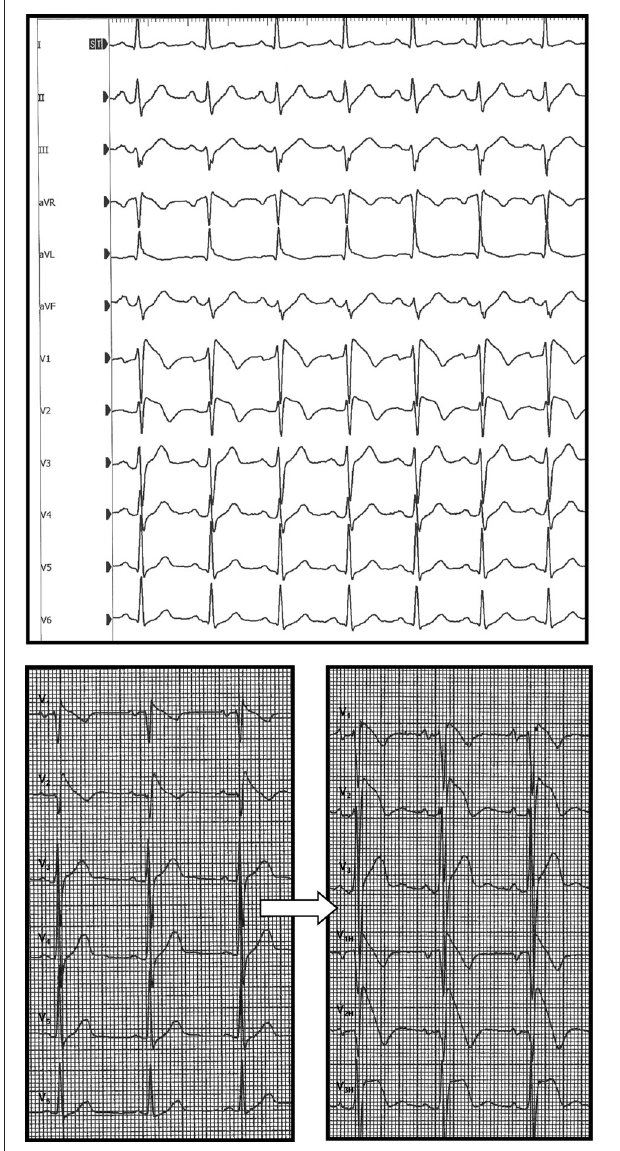
FIGURE 3 | Two typical BrS-ECGs (speed 25mm/s; gain 1mm/mV). Top: patient 33 with a baseline type 1 Brugada ECG (BrS group I).